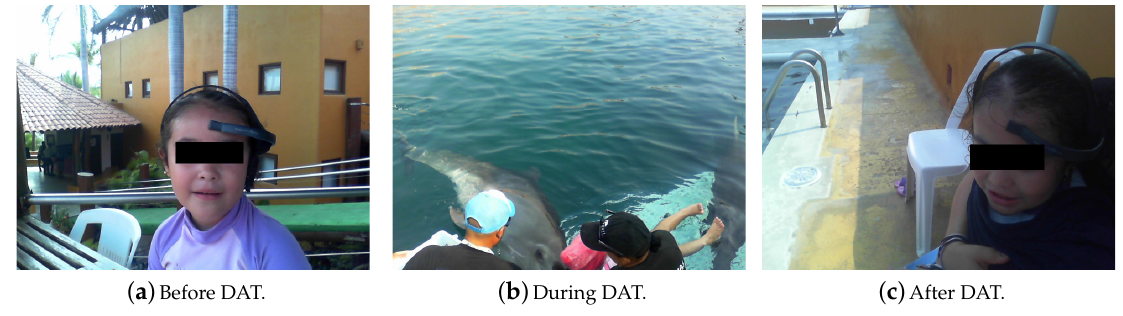
Figure 8. Method of obtaining EEG RAW